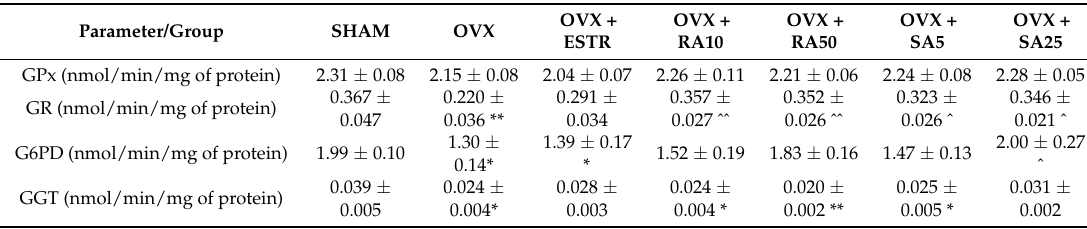
Table 3. Effects of rosmarinic acid and sinapic acid on the glutathione-related enzymes activities in the lenses of ovariectomized